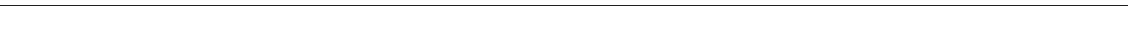
Fig. 2 Caspr1 is required for E. coli penetration through the BBB. a Gene-targeting strategy for the generation of Caspr1 conditional knockout mice with Cre- loxP recombination system. Two loxP sites were inserted before exon 4 and after exon 1 of Caspr1 gene, respectively. Then the Caspr1 loxP/loxP mice were crossed with VE-cadherin-Cre mice ( VE-cadherin Cre/ + ), producing Caspr1 loxP/loxP ; VE-cadherin Cre/ + mice in which Caspr1 was knocked out in endothelium (Caspr1 eKO). b The brain slices from Caspr1 eKO mice were prepared and stained with Caspr1 (Red) and CD31 (Green) antibodies. DAPI was used to identify nuclei (blue), with Caspr1 loxP/loxP mice served as control. Scale, 50 μ m. Images are representative of three independent experiments. c , d E. coli (1 × 10 4 CFUs) was injected subcutaneously into the mice. At 18 h post-infection, c the blood samples were collected for bacteremia measurement and the CSF were collected and cultured to indicate the passage of bacteria through the BBB. d Histological examination of the brain sections by hematoxylin and eosin (HE) staining was performed to assess the in fl ammation of the cerebral meninges. The zoom-in view showing the meningeal thickening and neutrophils in fi ltration (arrows) were provided. Scale, 100 μ m. The rate of meningitis occurrence was calculated by dividing the number of mice with both positive CSF culture and meningeal in fl ammation by the total number of mice. * P < 0.05 (Chi-square). e The mice were subcutaneously injected with E. coli (2 × 10 2 CFUs/mouse). The daily mortality was recorded and survival curves were plotted. n = 14 (each group). P < 0.05, Log-rank (Mantel – Cox) test. f Stable transfection with shRNA targeting Caspr1 was used to knockdown Caspr1 in HBMECs. Knockdown effects were analyzed by western blot, with GAPDH as loading control. Full blots are shown in Supplementary Fig. 8. Then the HBMECs were subjected to bacterial adhesion (top panel) and invasion (bottom panel) assay. Data are presented as relative invasion compared to normal HBMECs control, de fi ned as 100%. Values are mean ± SD of four